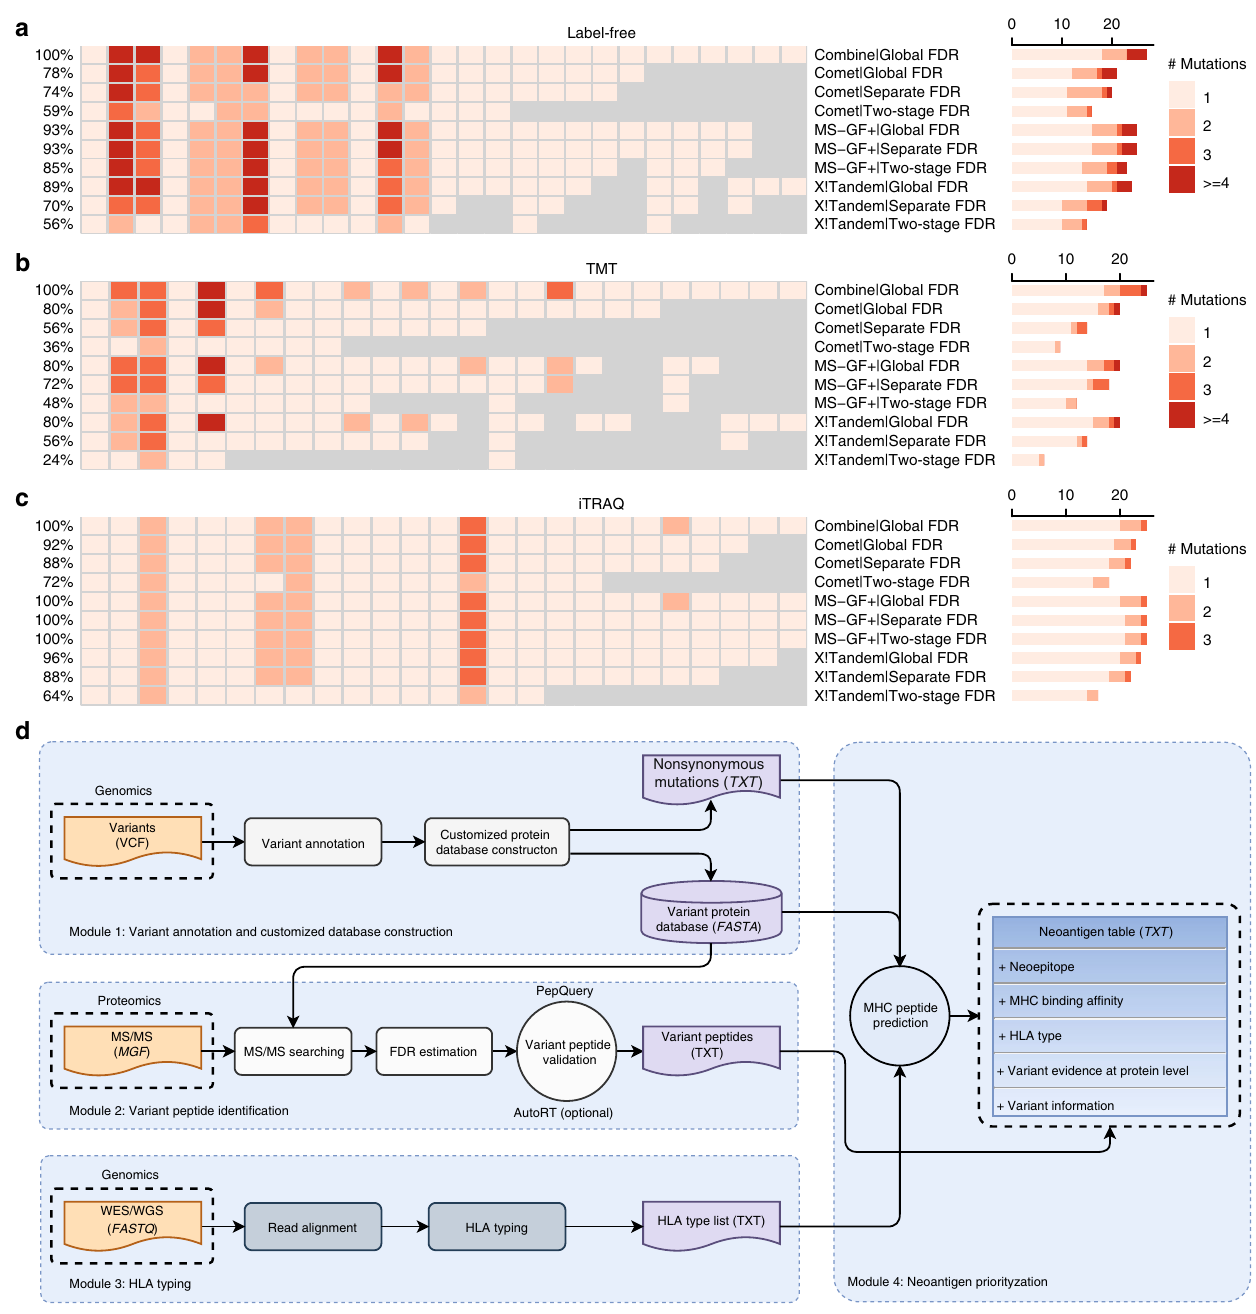
Fig. 7 Neoantigen prediction comparison and proteogenomics work fl ow. a – c Neoantigen prediction result for each sample in the label-free data a , the TMT data b , and the iTRAQ data c . Each column represents a sample and each row represents the neoantigen prediction result using a speci fi c method. The color of each cell represents the number of somatic mutations with predicted neoantigens. Only putative neoantigens encoded by proteomic- supported somatic mutations were considered. d Overview of NeoFlow pipeline for the proteogenomics-based neoantigen prioritization. Source data are provided as a Source Data fi